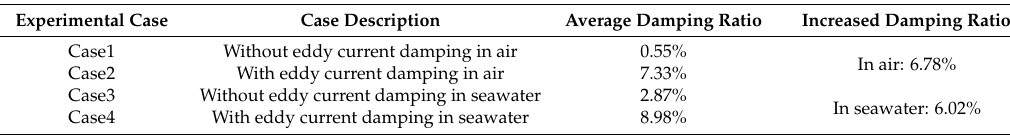
Figure 4. Damping ratio of cantilever beam in the first five vibration cycles. Table 1. Average damping ratio for each case.